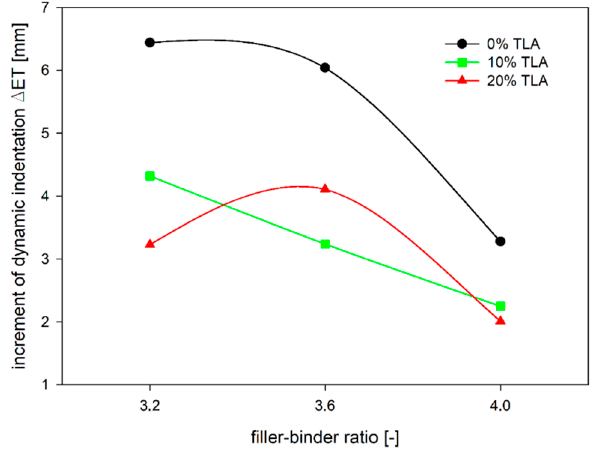
Figure 14. The dependence of increment of MA dynamic indentation on the filler–binder ratio for different TLA addition.